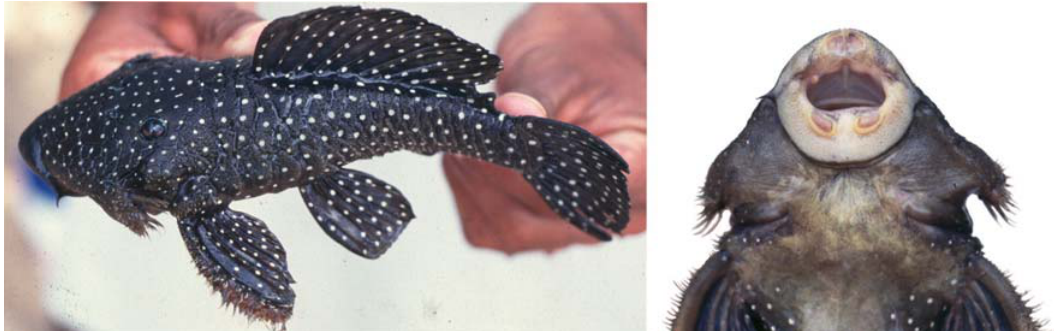
Fig. 2. Parancistrus nudiventris . Living color and detail of mouth of the holotype (INPA 15037, 152 mm